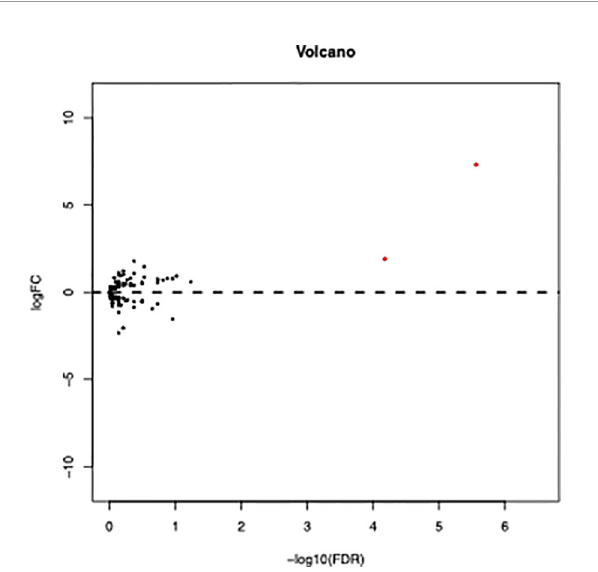
FIGURE 3 | Internal validation of the nomogram to predict OS likelihoods in patients using ROC curve. Blue line, ROC curve of three years survival; Red line, ROC curve of fi ve years survival.